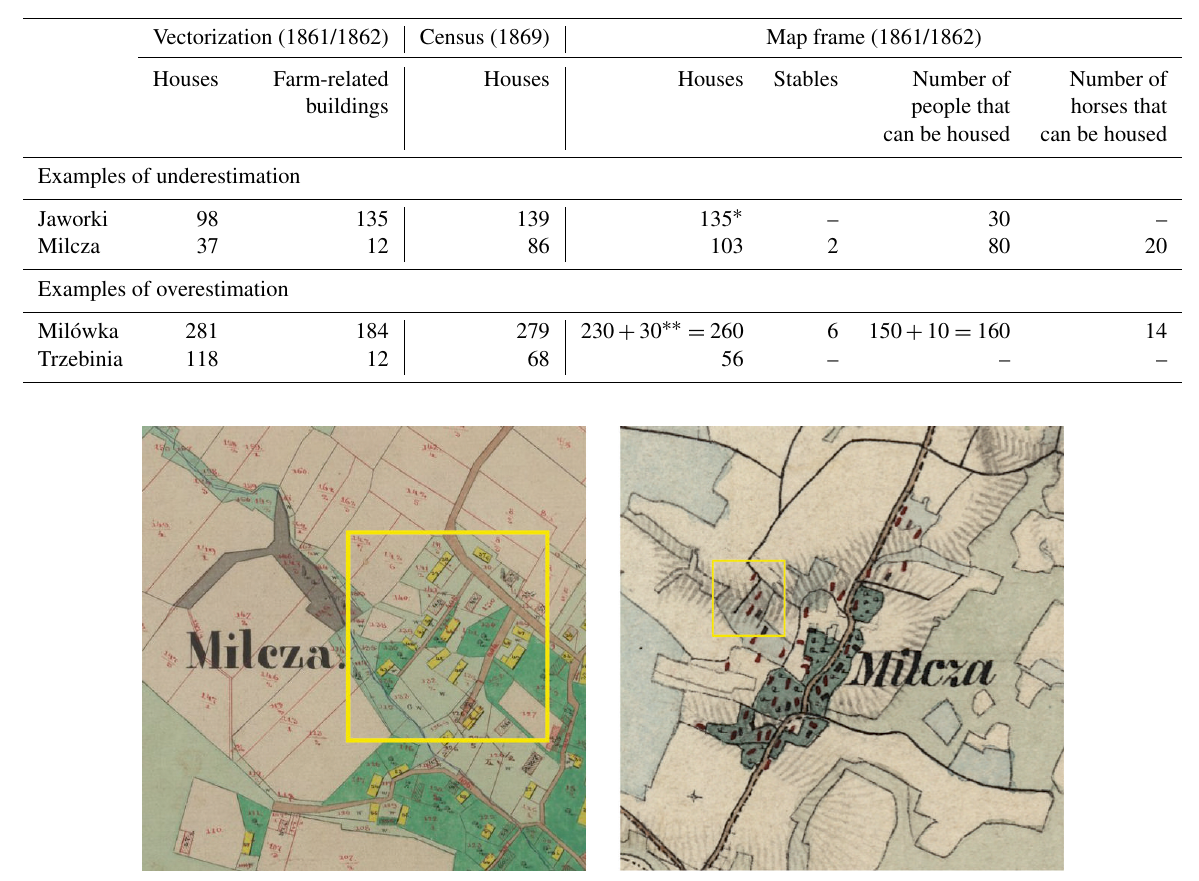
Figure 8. Comparison of a cadastral map (1851) and Second Military Survey map (1861/1862) that indicates a very high level of map generalization (source: National Archive in Przemy´sl, Austrian State